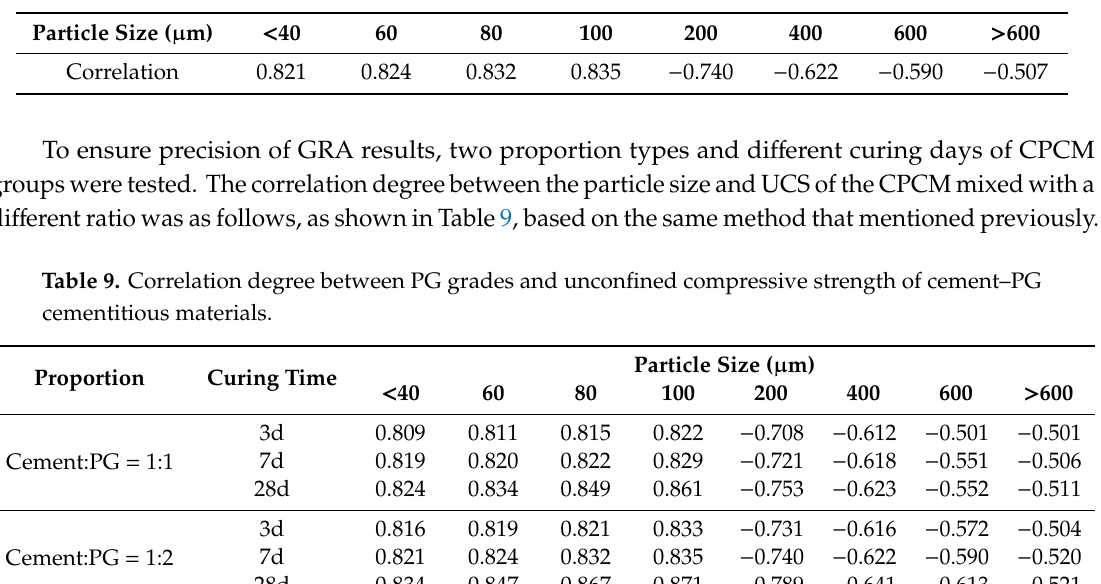
Table 8. Correlation degree between PG particle size and unconfined compressive strength.